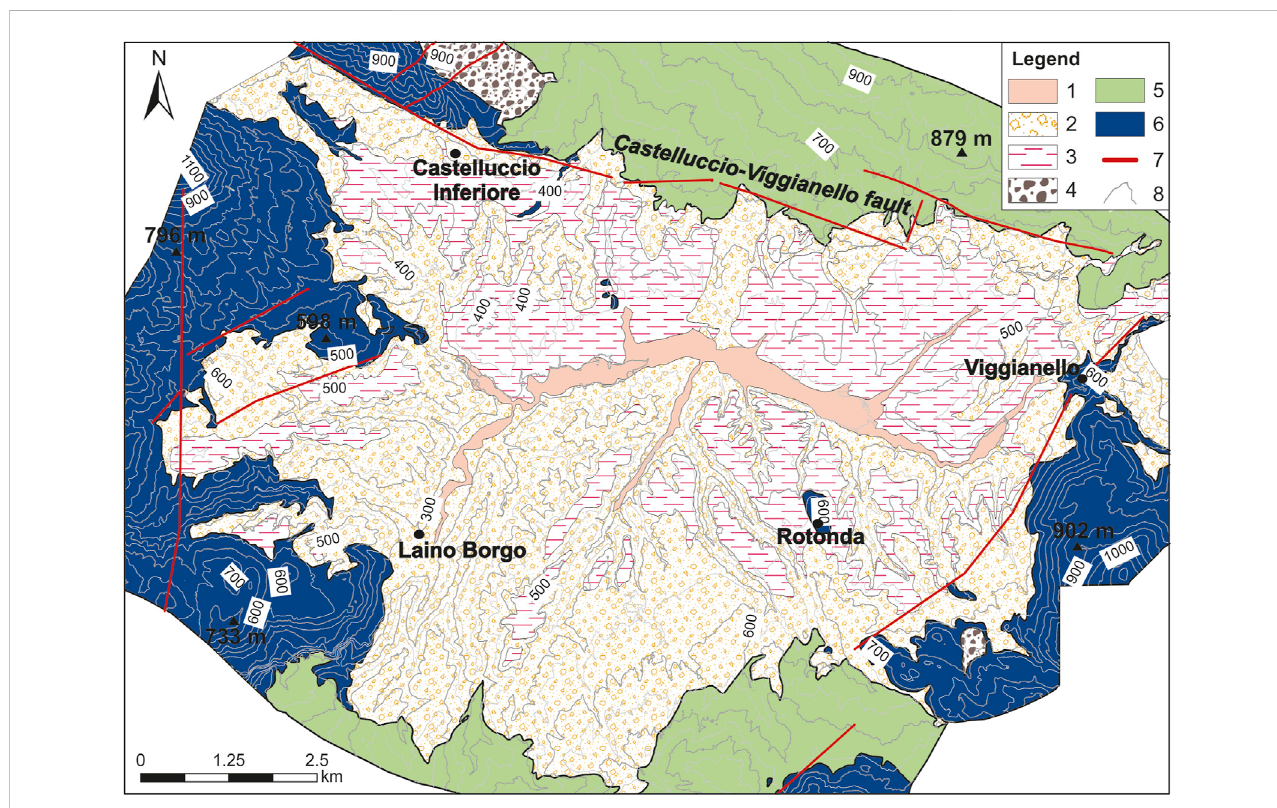
FIGURE 2 Geological map of the Mercure River basin. 1) Present-day alluvial deposits; 2) Middle Pleistocene alluvial fan deposits of the Mercure basin; 3) Middle- Pleistocene lacustrine deposits; 4) Lower Pleistocene slope and alluvial fan deposits; 5) Cretaceous to Oligocene ophiolite-bearing internal units;